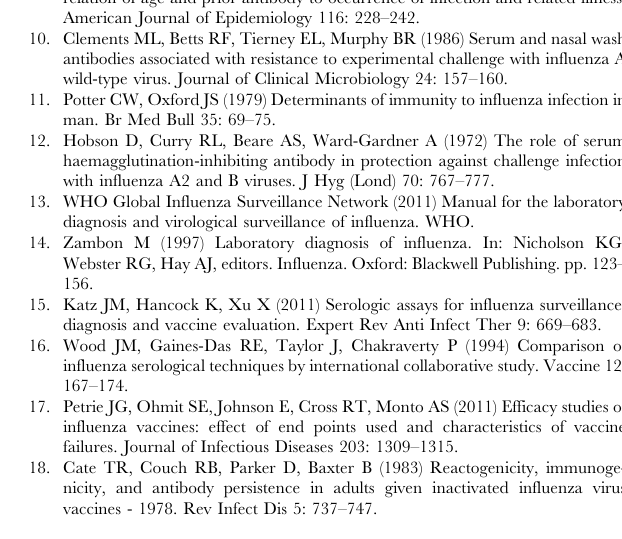
Figure S5 Model adequacy to age-specific data. Distri- bution of ‘‘observed’’ paired serology as predicted by the model (color bars) and as observed in the data (black point) as a function of season (2008, Spring 2009, Autumn 2009), subtype (H1N1, H3N2 and B) and age group ( , 18 y.o., 18–48 y.o., . 48 y.o.). In each panel, individuals are sorted by baseline AT levels on the y- axis. For a given baseline, the grey bar indicates the expected proportion of individuals with post AT level equal to baseline AT level; the yellow bar indicates the proportion with a 2 fold rise (2f.r.); the red bar indicates the proportion with a 4 fold rise or more (4f.r. + ); the green bar indicates the proportion with a decay. The black thin lines give the 95% CI. The legend gives the mean [95% CI]. A : H1, 2008, , 18 y.o. B : H3, 2008, , 18 y.o. C : B,